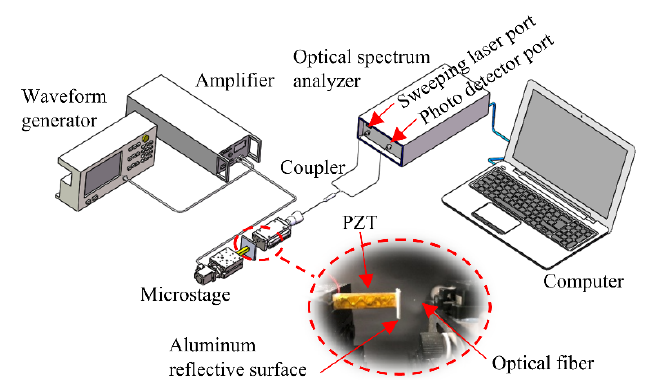
Figure 11. Experimental system diagram.